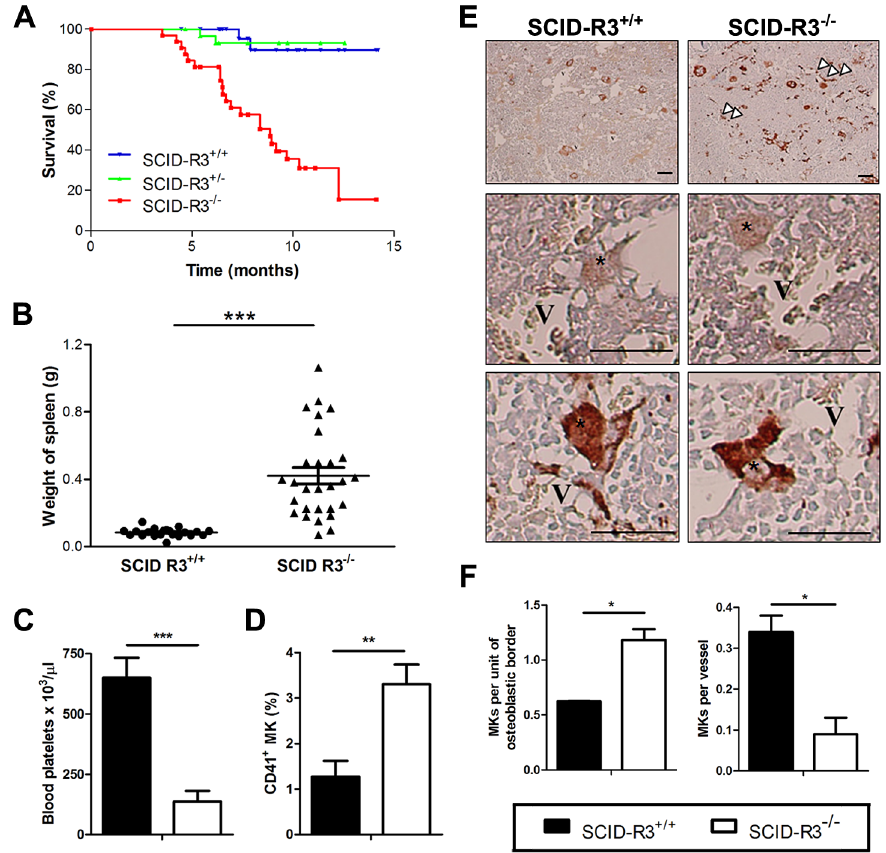
Figure 1. Decreased survival, splenomegaly, thrombocytopenia and megakaryocyte alterations in SCID-Rasa3 2 / 2 mice. A. Survival of irradiated SCID mice reconstituted with Rasa3 + / + (SCID-R3 + / + , n=28 mice), Rasa3 + / 2 (SCID-R3 + / 2 , n=31 mice) or Rasa3 2 / 2 (SCID-R3 2 / 2 , n=32 mice) embryonic liver cells. B. Spleen weight from age-matched SCID-Rasa3 + / + and moribund SCID-Rasa3 2 / 2 mice. The mean 6 SEM are also presented in each group of mice. A splenomegaly was defined as a spleen weight over 0.168 g (i.e. twice the mean spleen weight of SCID-Rasa3 + / + mice). C. Blood platelet counts in age-matched SCID-Rasa3 + / + (black column, n=9) and moribund SCID-Rasa3 2 / 2 (white column, n=15) mice. Results represent the mean 6 SEM of platelets per m l of blood. D. Mean 6 SEM of CD41 + megakaryocyte (MK) percentages detected by flow cytometry in the bone marrow isolated from age-matched SCID-Rasa3 + / + (black column, n=17) and moribund SCID-Rasa3 2 / 2 (white column, n=20) femurs. E. vWF-stained bone marrow sections of SCID-Rasa3 + / + and SCID-Rasa3 2 / 2 femurs 3 months after SCID mice reconstitution. V: vessel; *: megakaryocyte; arrowheads: abnormal vWF deposits. Scale bars: 50 m m. F. Quantification of megakaryocytes (MKs) in the osteoblastic and the vascular niches of SCID-Rasa3 + / + (black columns) and SCID-Rasa3 2 / 2 (white columns) bone marrow femurs 3 months after irradiation/reconstitution. Results represent the mean 6 SEM of the number of megakaryocytes per unit of osteoblastic border, or per vessel. Statistics (unpaired t test): *: P , 0.05; **: P , 0.01; ***: P , 0.001.